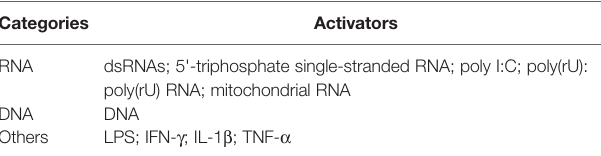
TABLE 1 | Activators of